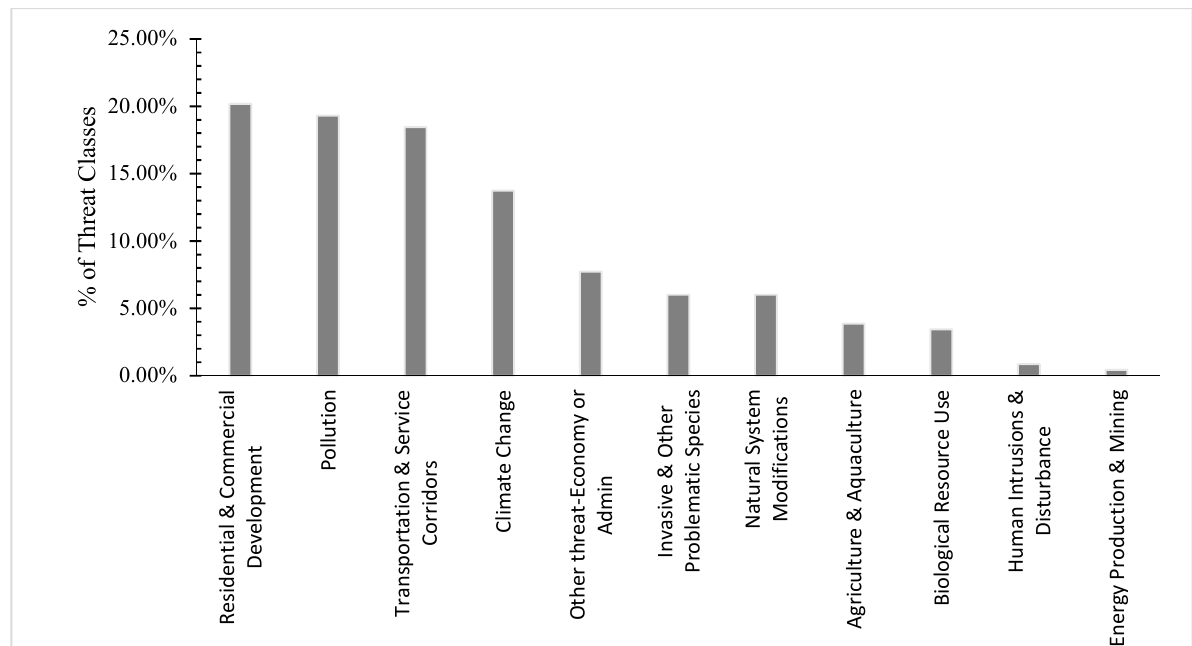
Figure 2. Classification of the major threats in the Gediz Delta based on the IUCN threats classification system using a systematic literature review (n = 233 sources).